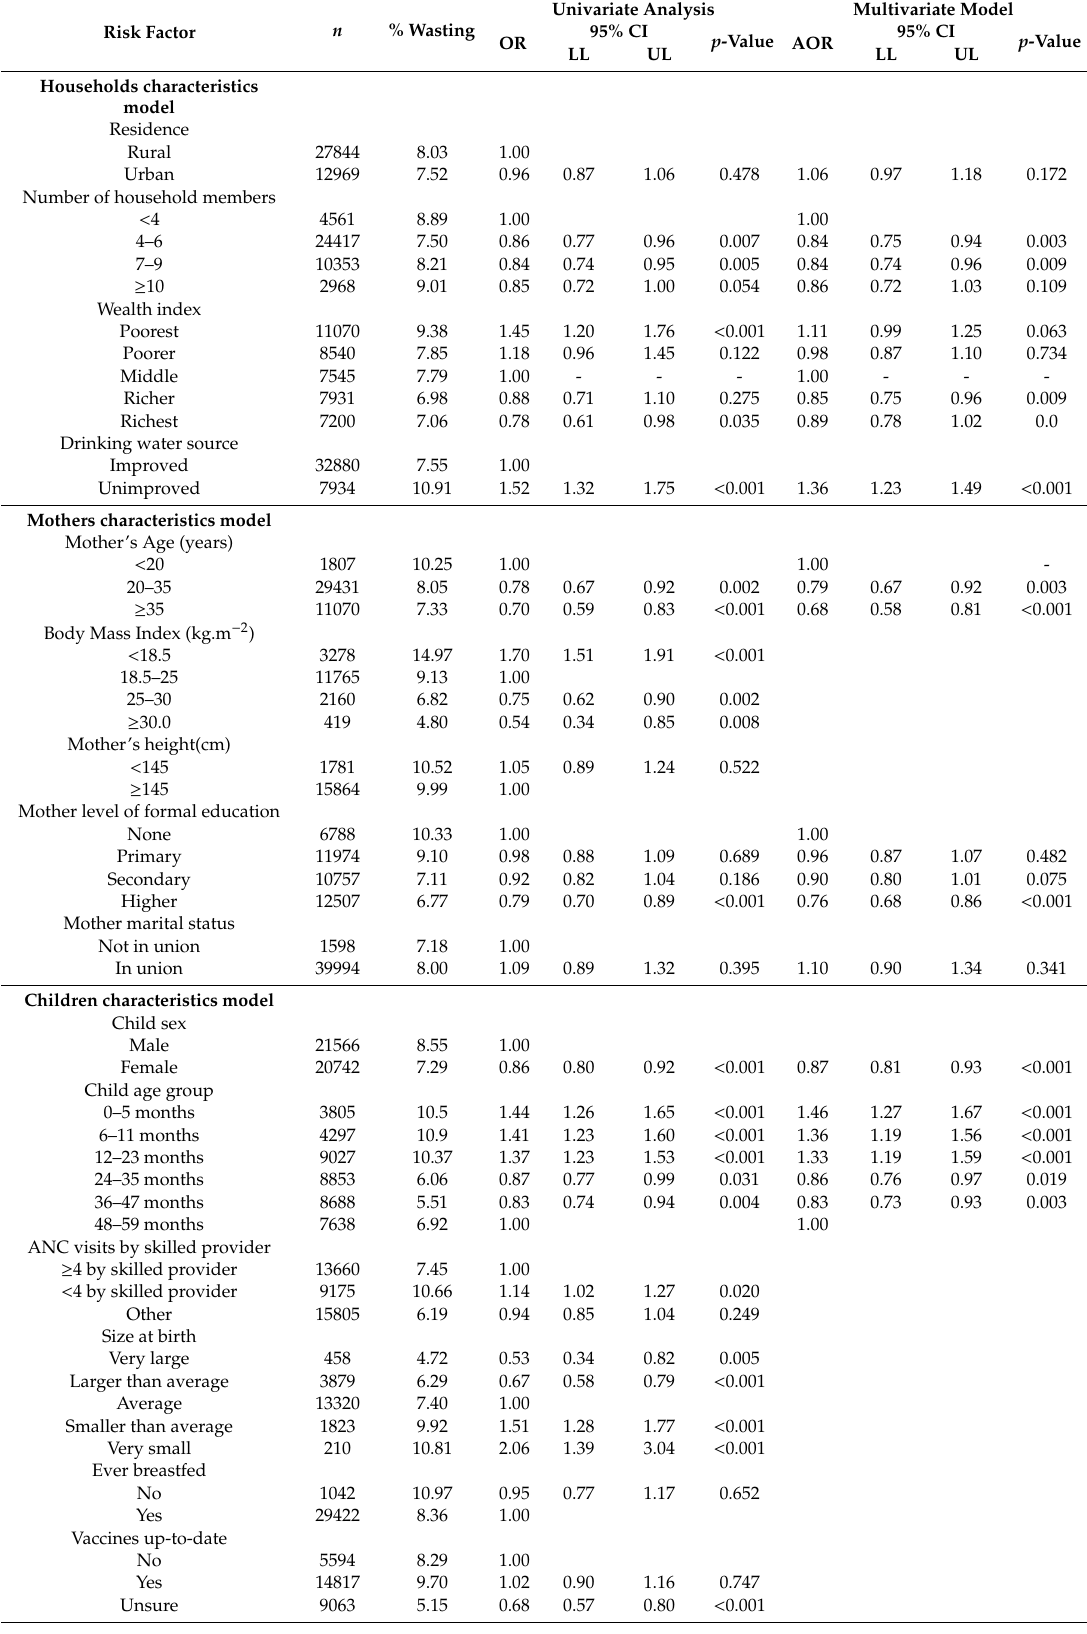
Table 4. Predictors of wasting: univariate and separate multivariate multilevel regression analyses for the six